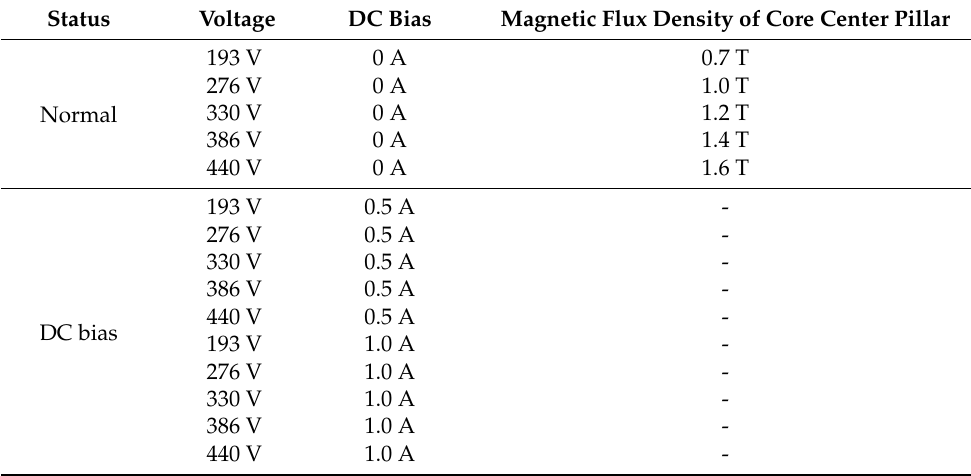
Table 1. Voltage levels and excitation plans for test.